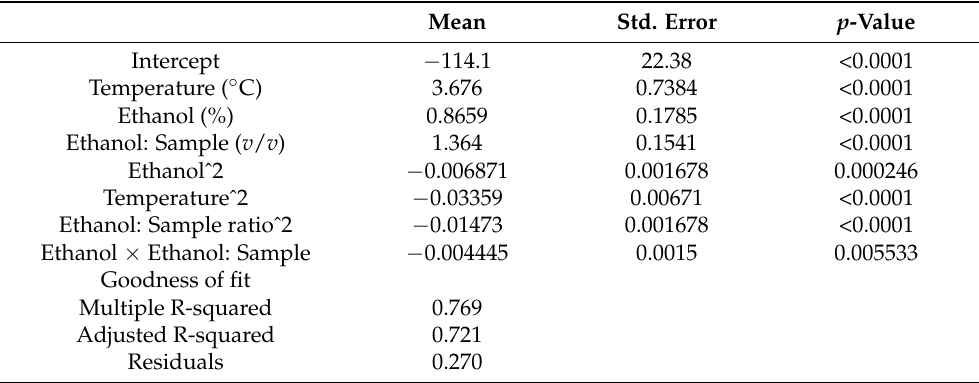
Table 2. Parameter estimates of the response surface model for estimating the yield (%) of extracts obtained from quinoa fermented by Monascus purpureus supplemented with fish hydrolysate and sodium chloride. Mean Std. Error p -Value Intercept − 114.1 22.38 <0.0001 Temperature ( ◦ C) 3.676 0.7384 <0.0001 Ethanol (%) 0.8659 0.1785 <0.0001 Ethanol: Sample ( v / v ) 1.364 0.1541